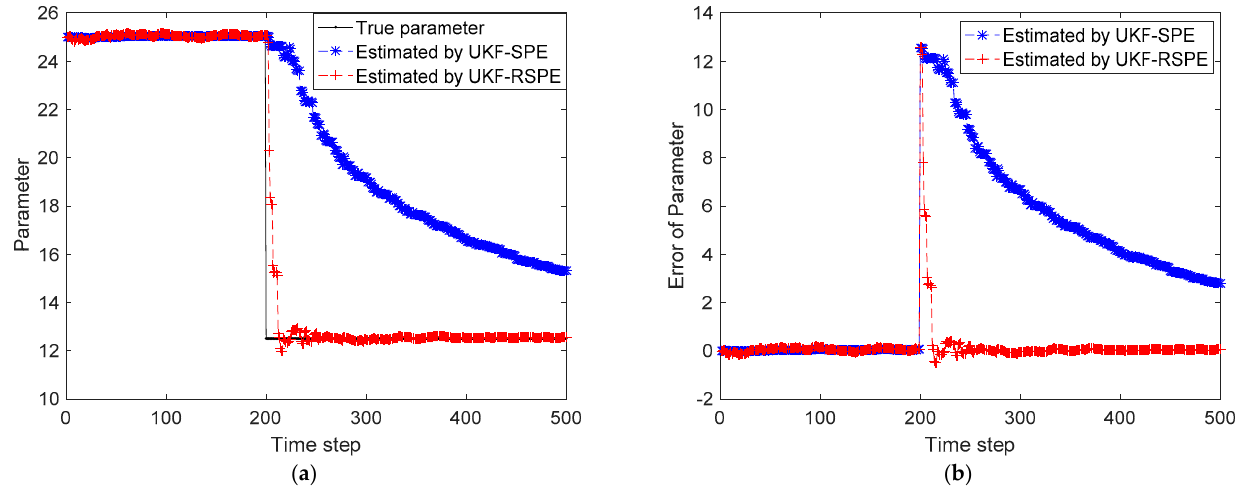
Figure 6. The comparison of the estimated results of parameter in Case Study 1: ( a ) estimated parameter; ( b ) parameter error.